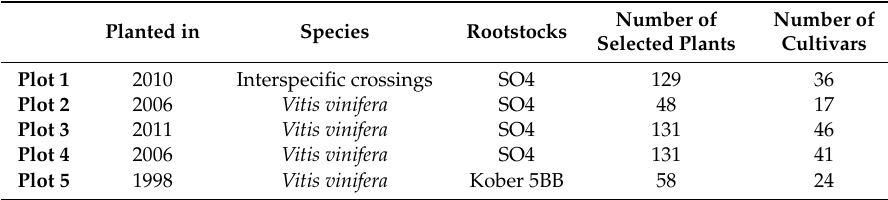
Table 1. Information about experimental